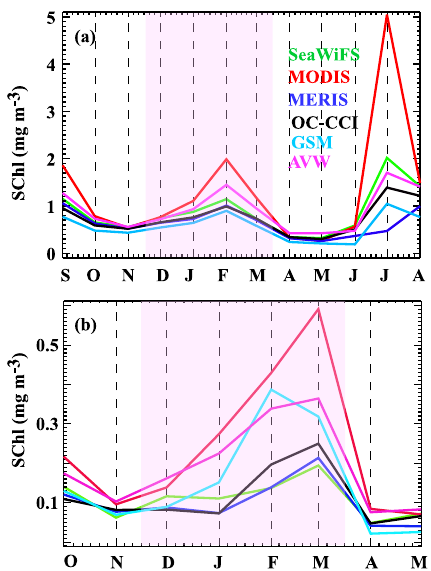
Figure 3. (a) Climatological monthly seasonal cycle of NAS- averaged SChl for all satellite products. (b) Standard deviation of monthly (October–May) NAS-averaged SChl for all satellite prod-